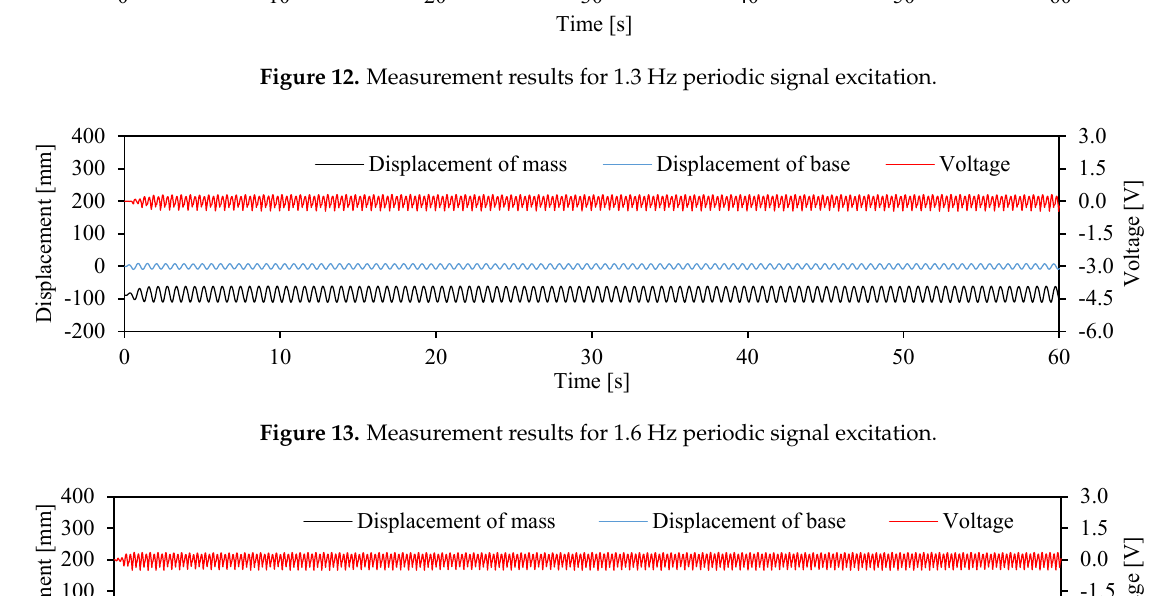
because the excitation frequency was similar to the natural frequency of the vibration